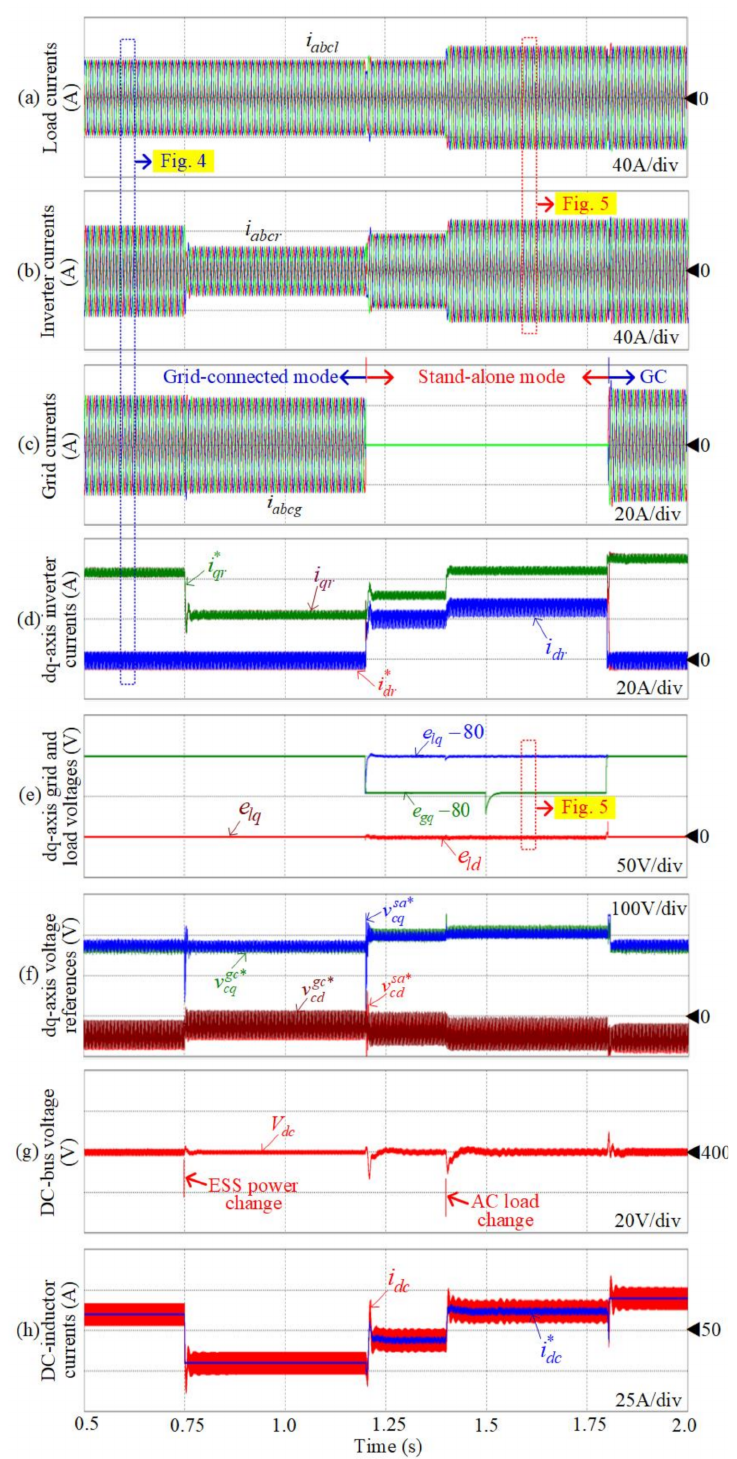
Figure 3. Control performance of the microgrid under both the grid-tied and stand-alone modes and transition: ( a ) load currents; ( b ) inverter output currents; ( c ) grid currents; ( d ) dq -axis components of inverter currents; ( e ) dq -axis components of the grid and load voltages; ( f ) voltage references for both modes; ( g ) DC-bus voltage; ( h ) DC-inductor